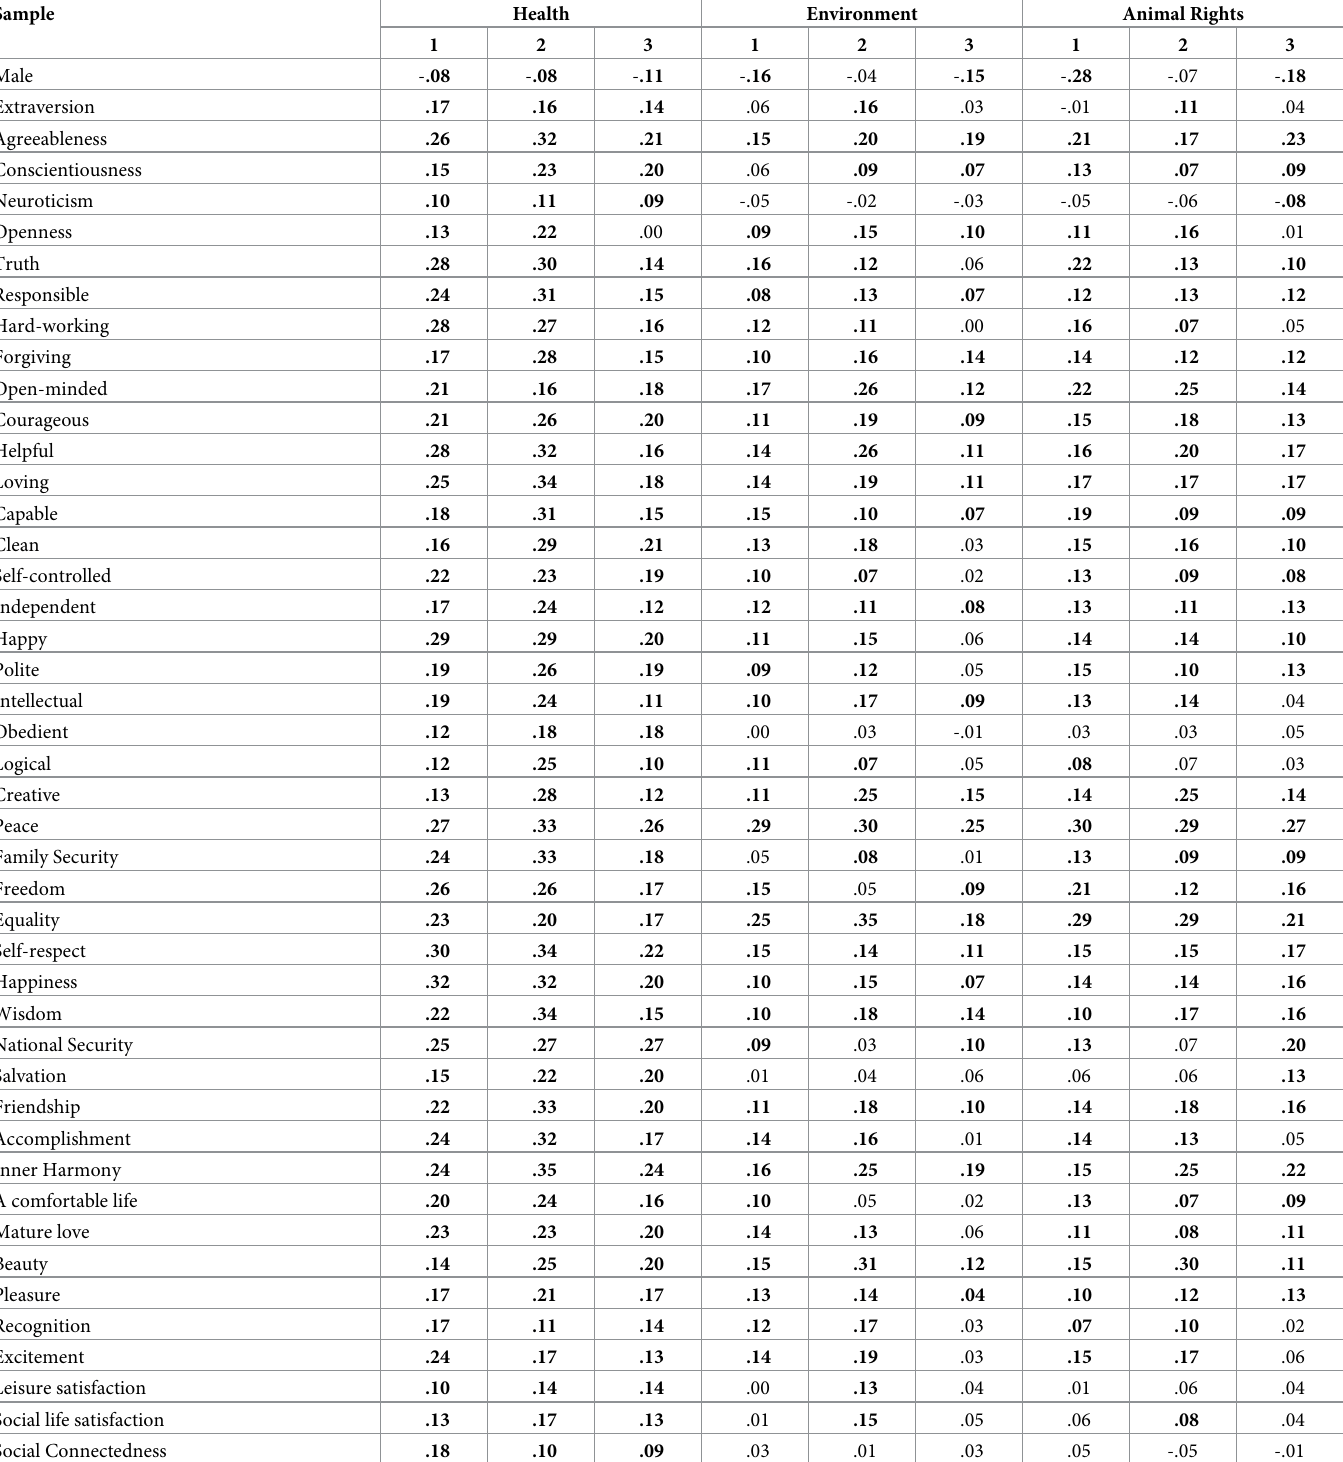
Table 5. Bivariate correlations between plant-based motives and criterion variables for which at least one motive correlated significantly (p < .01) across samples 1, 2, and